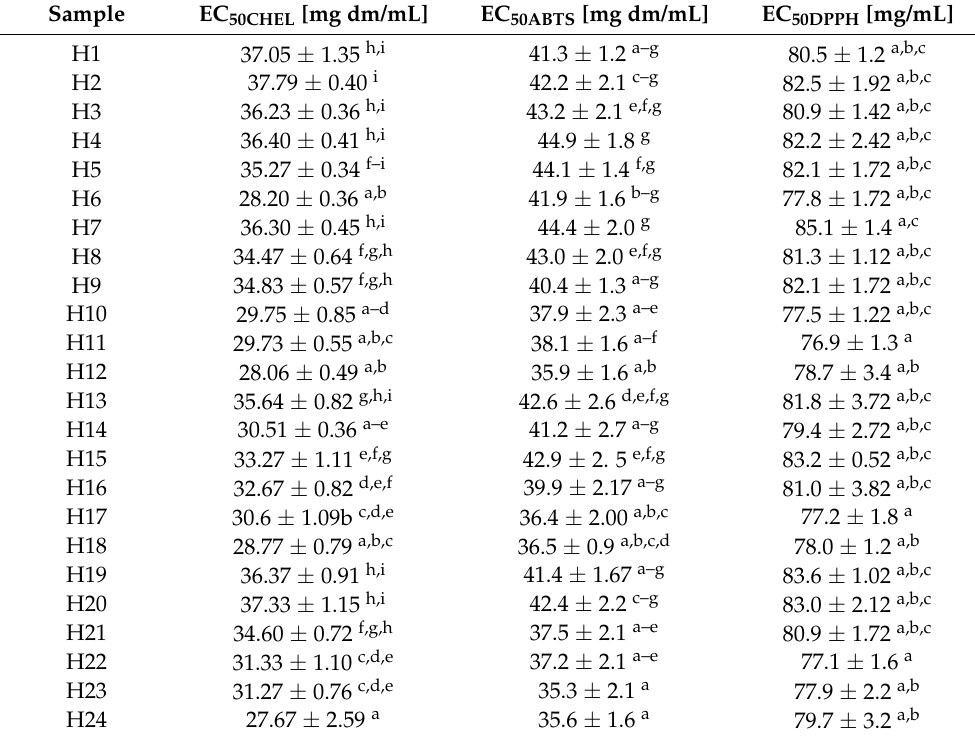
* v d —speed of the disc, v k —speed of the classifier. Table 5. Antioxidant activity of